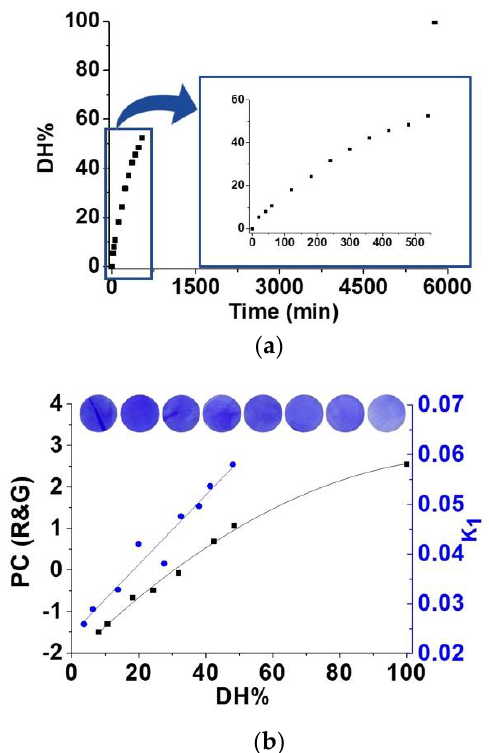
Figure 6. ( a ) Degree of hydrolysis of a beefsteak obtained by UV/Vis using the Nielsen et al. procedure (DH% = [(A sample − A blank )/(A 100% − A blank )] × 100; A = absorbance) vs. time [62]. Experimental conditions : 12.5 g of beefsteak and 62.5 mg of papain were made up to 250 mL with pH 7 buffer solution. The mixture was stirred at 50 °C and aliquots of 5 mL were taken at different times. Additional information in SI-S12. ( b ) Blackline: Correlation of the RGB method with DH%. PC (R&G) parameter was obtained by multivariable analysis of parameter R & G from digital images of the discs of F (3)-Cu-D , after immersion for 60 min in the filtered aliquots from the hydrolysis reaction. Blueline : Correlation of the kinetic rate constants of the kinetic of displacement of the dye by amino acids in the solid sensory F (3)-Cu-D . The rate constants were calculated using the UV/Vis absorption data obtained from the solution where the sensory discs were immersed.